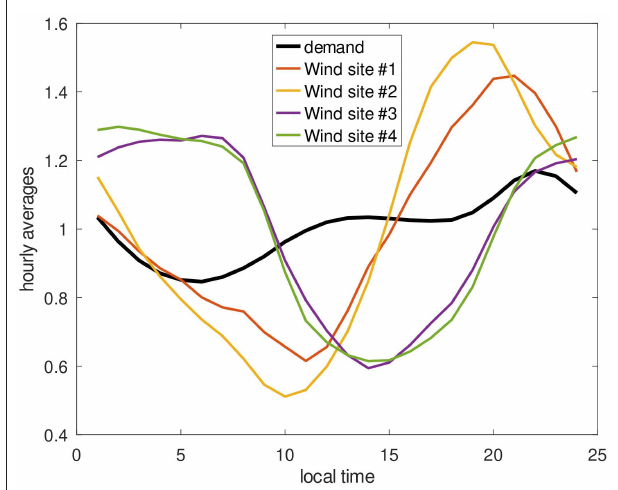
FIGURE 7 | Hourly averages of electricity load of wind sites #1 and #2 (Sosneado and Arauco), #3 and #4 (El jume and Achiras) and electricity load. The resemblance between renewables time series and electricity load is reflected in their correlation, as shown in Figure 6 .